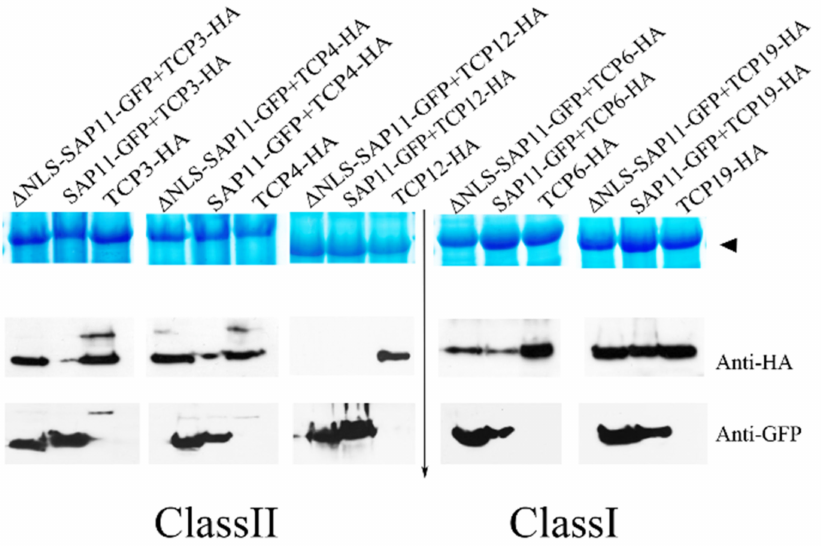
Figure 7. TCP destabilization assay. The relative quantities of AtTCPs (3, 4, 6, 12, and 19) were monitored in the presence of AP_SAP11-like_PM19 and AP_SAP11-like_PM19 ∆ 40–56 when they were transiently expressed from the same vector in N. benthamiana . The amounts of AtTCPs and SAP11 were examined using a monoclonal anti-HA for detecting HA-AtTCPs (middle panel) and anti-GFP for SAP11-GFP ( low panel ) in Western blotting analysis. For controlling the total protein loading amount, the large subunit of Rubisco visualized with Coomassie Brillant Blue staining is indicated by an arrowhead ( upper panel